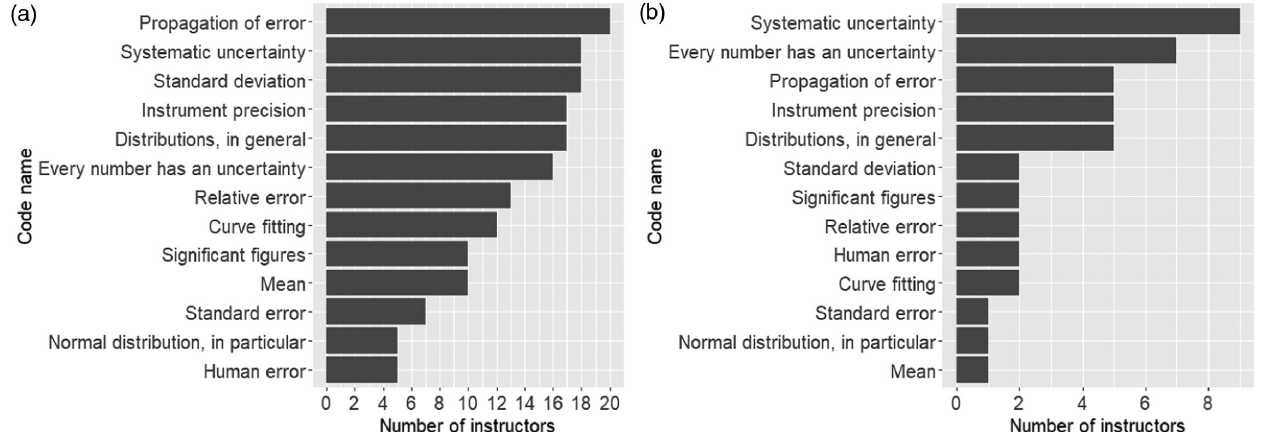
FIG. 2. The number of interviews in which instructors mentioned concepts (a), and only those concepts they identified as important (b), broken down by the emergent codes in Table IV. As a reminder, we interviewed 22 instructors ( N